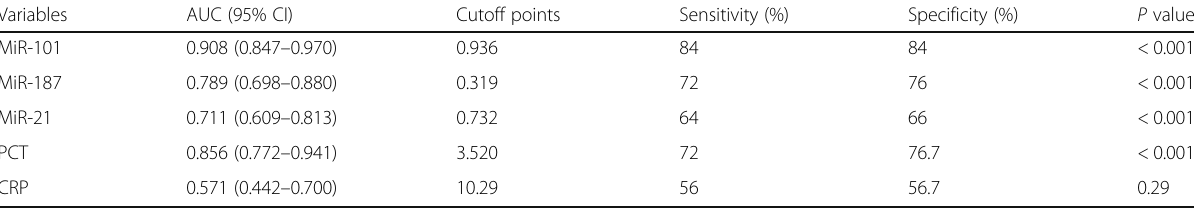
Table 2 Performance characteristics of miRNAs 101, 187, and 21 expressions (2 −Δ Ct ) and clinical indicators in sepsis and SIRS